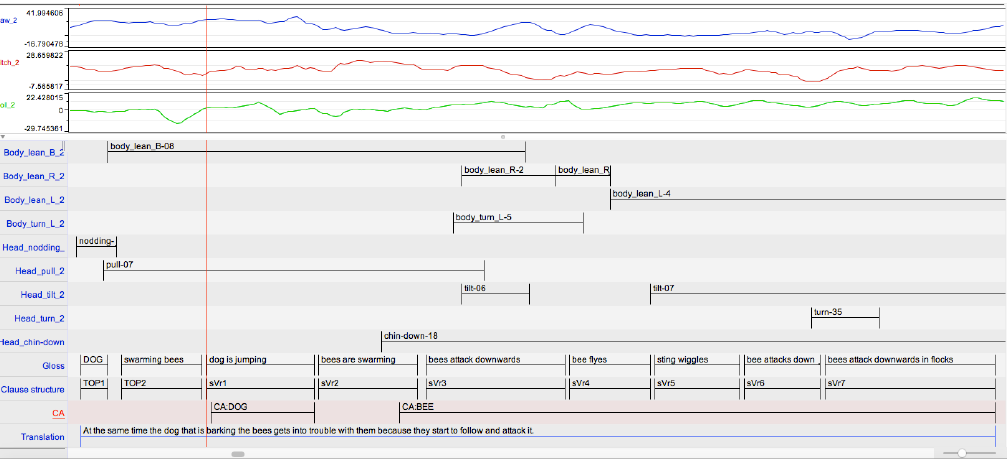
Figure 7. ELAN screenshot of Figure 5, with added computer-vision data and non-manual annotations. Figure 7 depicts the same example as in Figure 5, to which computer-vision data and annotations for non- manual phonetic activity have now been added. In Figure 7, the computer-vision data for the yaw, pitch and roll angles of the head position do not show any significant head movement contours which could align temporarily with any of the chained clauses – or with any bits of discourse (the two topics, on the other hand, seem to be layered with a specific contour). Instead, from the computer-vision point of view, the head moves relatively erratically and is guided primarily by the signer’s intention to portray, firstly, the activities of the dog and, secondly, the activities of the bee(s). However, when we look at the non-manual annotations, we can see the cohesive binding effect of the head movements at discourse level. This is particularly salient for the part of the discourse that consists of the six final clauses of the clause chain occurring with the CA in which the signer represents the bee(s): all six clauses are associated with a continuous chin-down head posture, and the three final clauses of the chain also occur with a continuous head tilt. As noted at the beginning of Section 3.3.1 (and discussed more specifically, for example, in Puupponen 2018), the movement of the head is closely linked to the movement of the whole body. This connection is exemplified in Figure 7 by the two longest lasting body annotations, which are nearly time-aligned with the two longest head